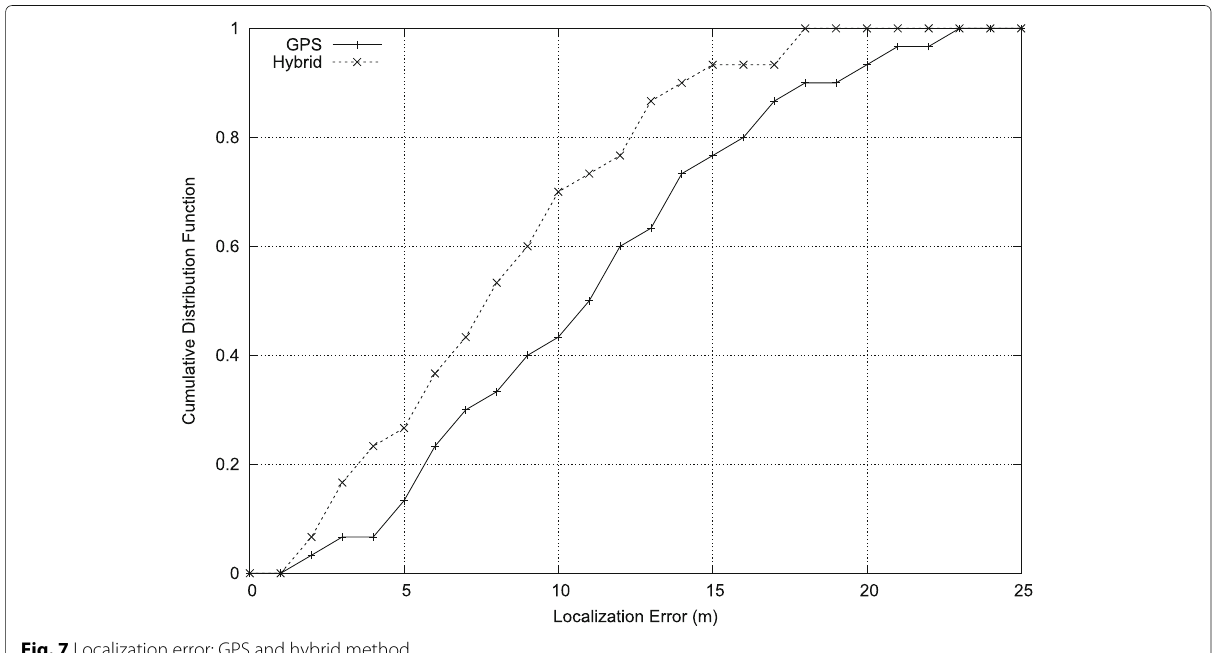
Fig. 7 Localization error: GPS and hybrid method